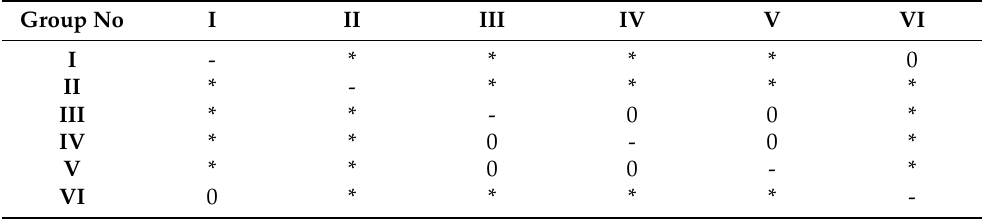
Table A4. The membrane thickness of capillary tuft in rats fed with normal diet. Statistical differences between all experimental groups; * significant, 0 insignificant.